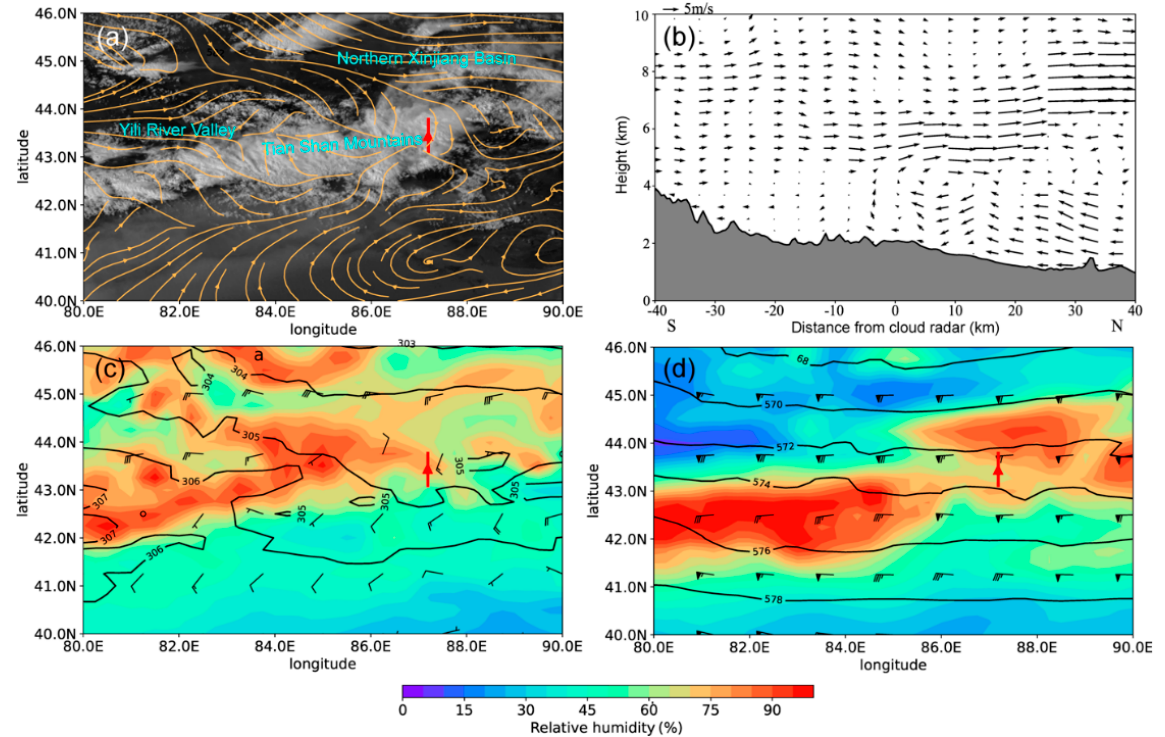
Figure 2. ( a ) Visible image observed from the FY4A satellite and streamlines at 800 hPa; ( b ) Cross − section of wind vectors along the red line shown in ( a ); ( c , d ) Geopotential height (black lines), wind barbs, and relative humidity (colored) at 700 hPa and 500 hPa at 9:00 UTC on 27 July 2019. S and N below ( b ) indicate south and north of the cloud radar.